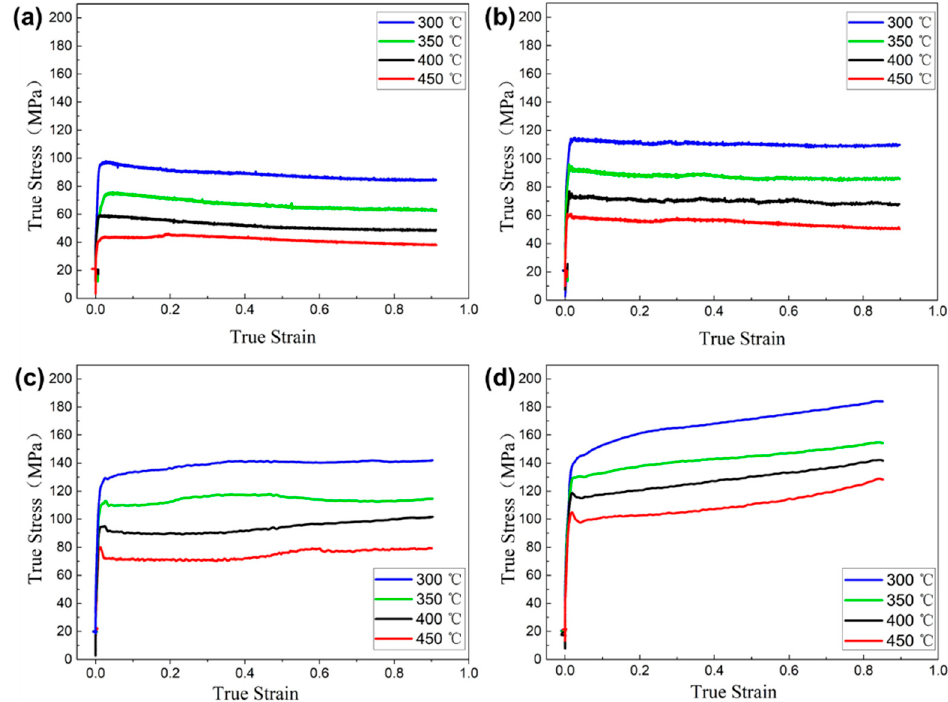
Figure 4. The true stress–strain curve of the first layer of the gradient alloy by spray deposition: ( a ) 0.001 s − 1 , ( b ) 0.01 s − 1 , ( c ) 0.1 s − 1 , and ( d ) 1 s − 1 .